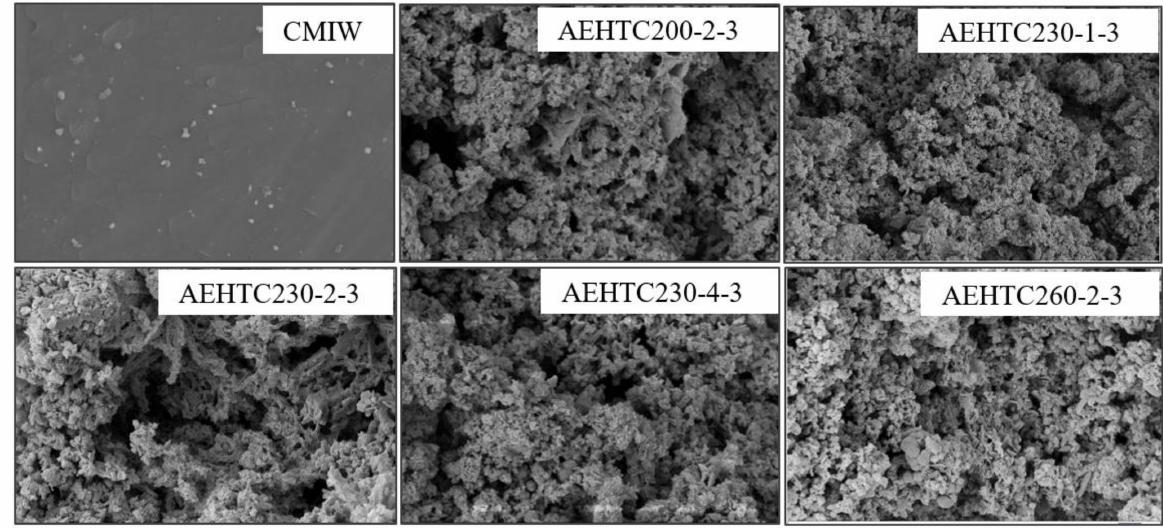
Figure 1. N 2 adsorption–desorption isotherms ( a ) and pore size distributions ( b ) of AE-CMIW hydrochar.